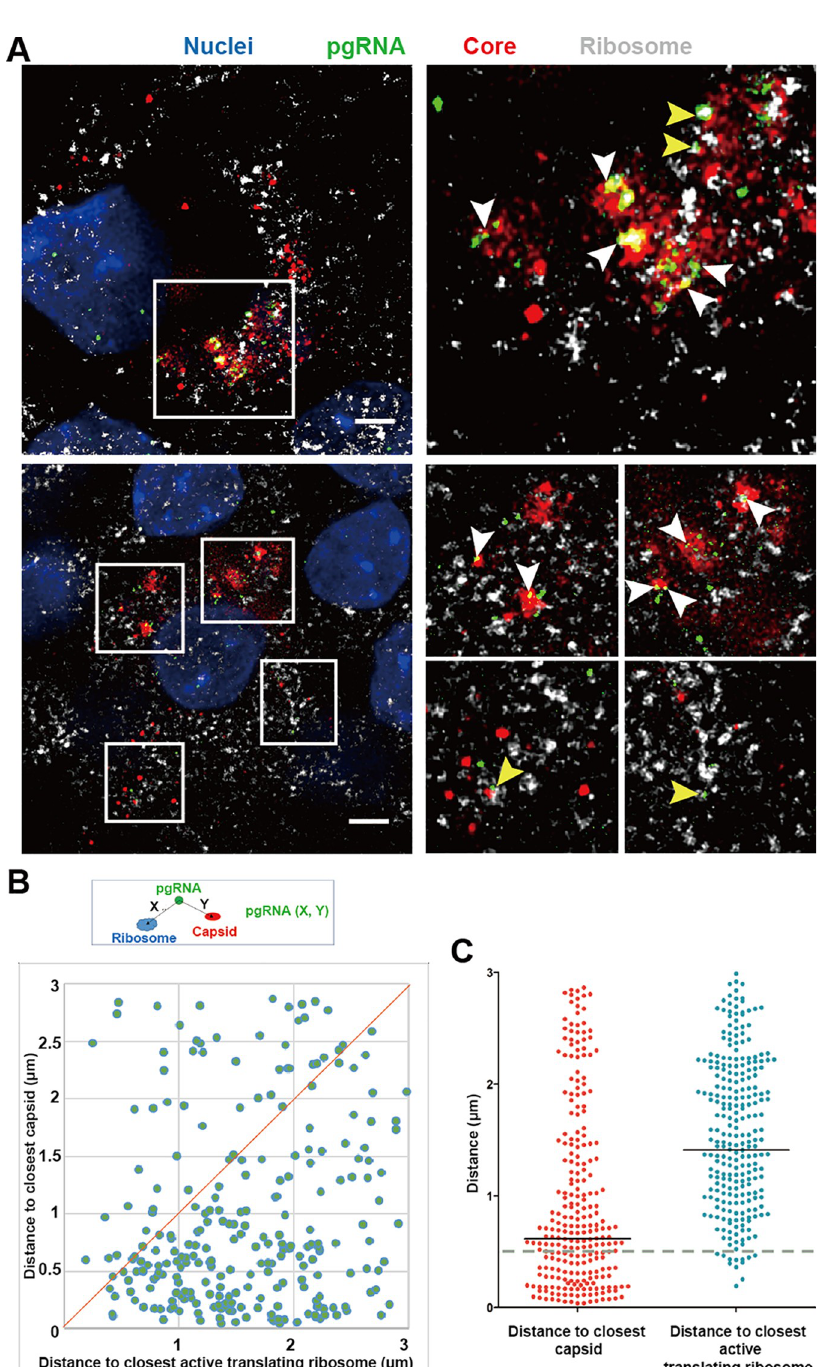
Fig 5. Colocalization of HBV pgRNA with actively translating ribosomes and capsid in the HepG2-NTCP infection system. (A) HepG2-NTCP cells were infected with HBV at MOI = 1000 and at 9 days post-infection the cells were fixed and processed for pgRNA detection followed by puromycin (Puro) labeling for puromycylated ribosomes and capsid. Colocalization of pgRNA and capsid were presented by white arrows. colocalization of pgRNA and actively translating ribosomes were presented by yellow arrows. Scale bar, 4 μ m. (B) Distance between pgRNA and closest puromycylated ribosomes (X), between pgRNA and closest capsid (Y) were shown as a two-dimensional plot. (C) The distribution of aforementioned X and Y values were shown as a scatter plot with marked mediums. A dashed line of 0.5 μ m, the threshold for defining colocalization, was shown.